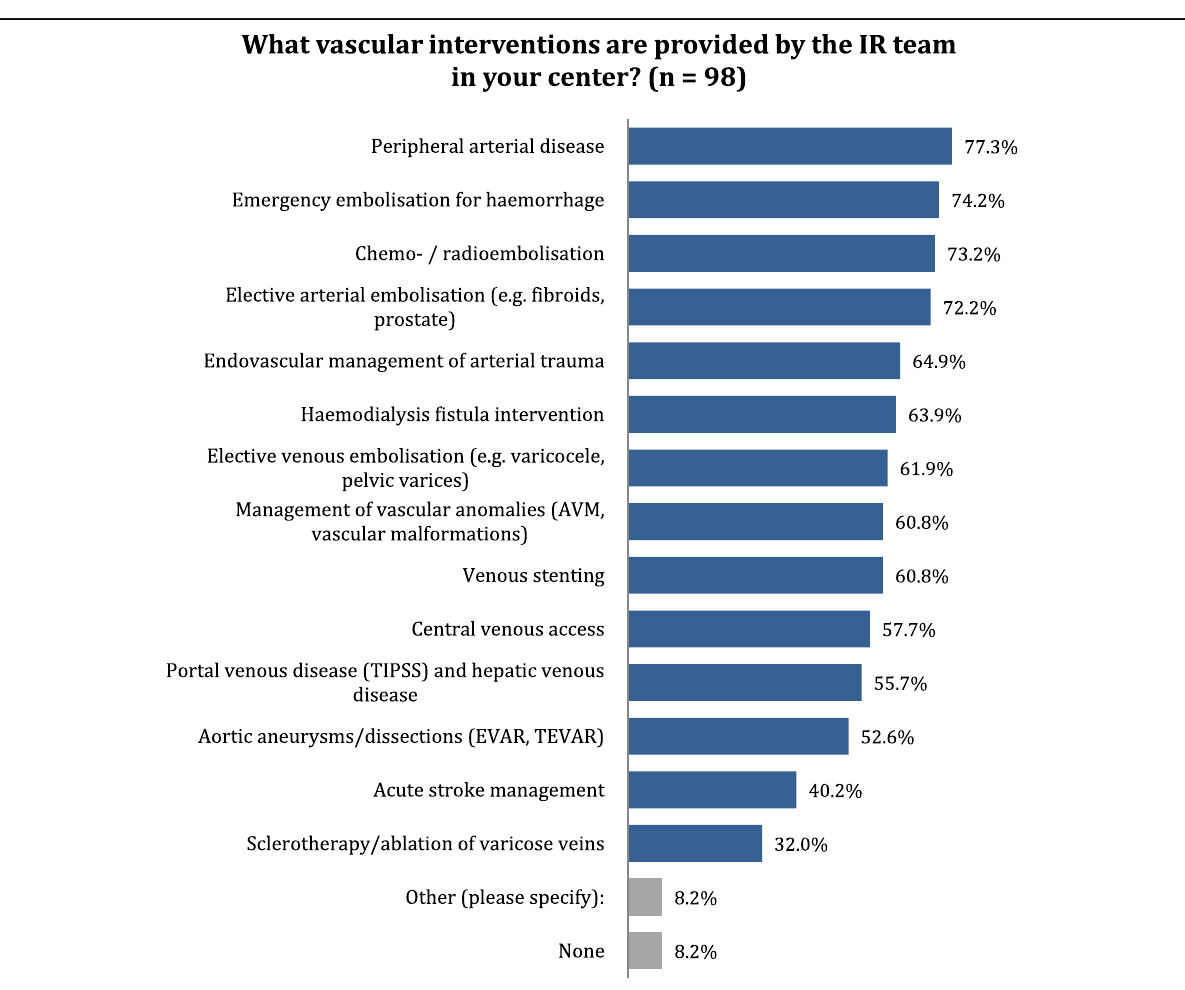
Fig. 3 Distribution of answers to question 27: What vascular interventions are provided by the IR team at your